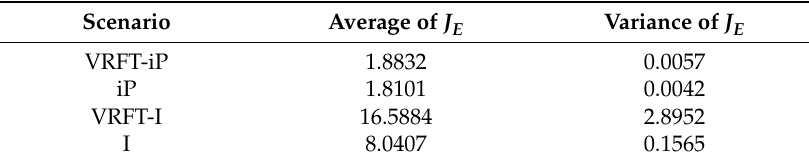
Table 1. Objective function values in the experimental case study (1).